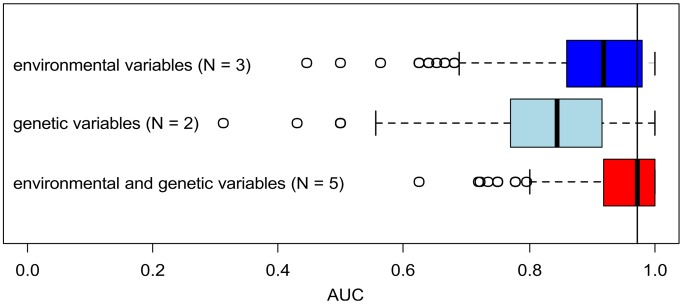
Results of jackknife testing of variable importance for the SESR modeling.The boxplots show the median goodness-of-fit values (AUC) of the models based on three environmental (bio11, bio12, altitude), two genetic (DTN, HD), and all five variables together with their respective 95% confidence limits (whiskers).